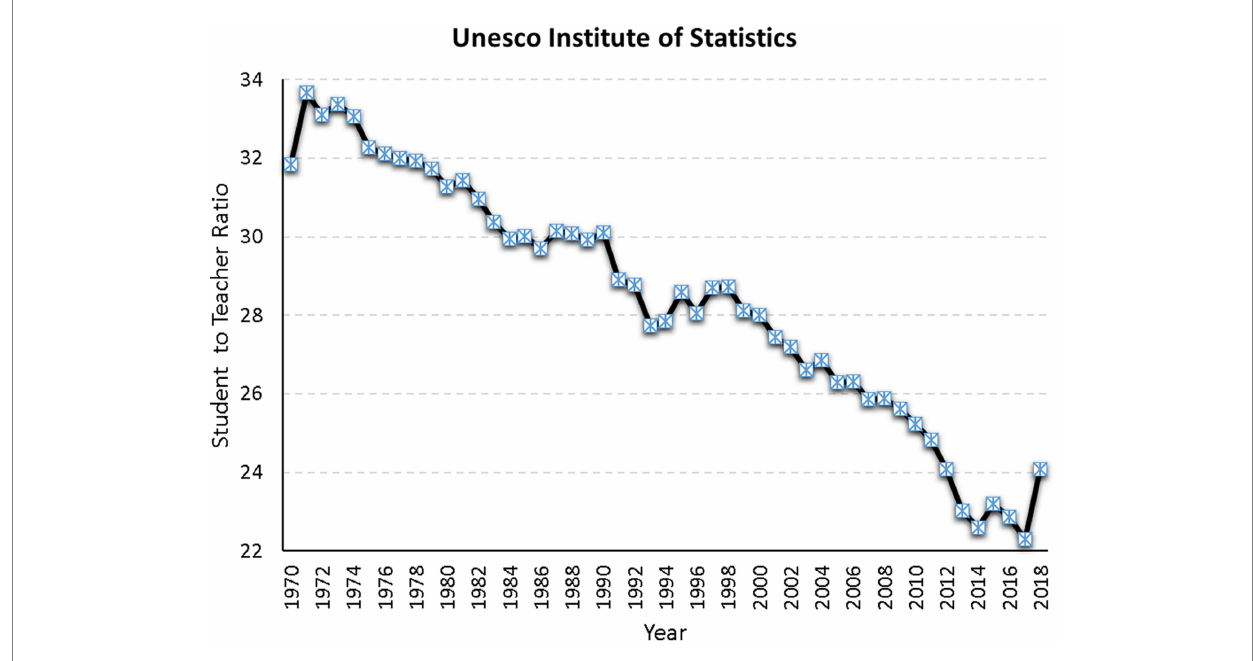
FIGURE 2 Ratio of Student to Teacher using world data from 1970 to 2018